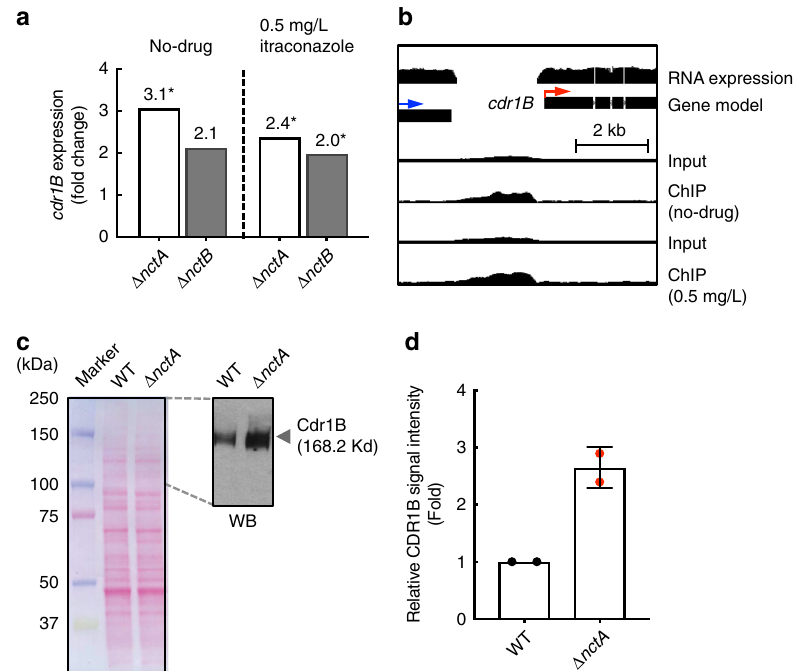
Fig. 6 Defects in the NCT complex leads to transcriptional de-repression of cdr1B and over-production of CDR1B protein. a Expression levels of cdr1B transcripts in the nctA null and the nctB null mutant in RNA-seq analysis: *, FDR < 0.05. b In vivo binding of NctA on the 5 ′ -upstream region of cdr1B . Tracks for the NctA ChIP-seq (ChIP) and their input DNA control (Input) are visualised in the UCSC genome browser together with annotated gene models and their transcript, which are expressed in the no-drug conditions. The direction of the target gene and the 5 ′ -proximal gene are shown in red arrows and blue arrows, respectively. c Representative western blot (WB) showing the increase in CDR1B protein levels in the Δ nctA mutant. Cell-free extracts were resolved via SDS-PAGE, and probed for CDR1B using a CDR1B-speci fi c antibody. Ponceau S staining was performed as an overall loading control. d Relative protein levels of CDR1B. The relative intensity of the CDR1B signal was quanti fi ed by densitometric scanning. The data represent the mean results of two biological replicates, and the error bars signify the standard deviations. Source data are provided as a Source Data fi